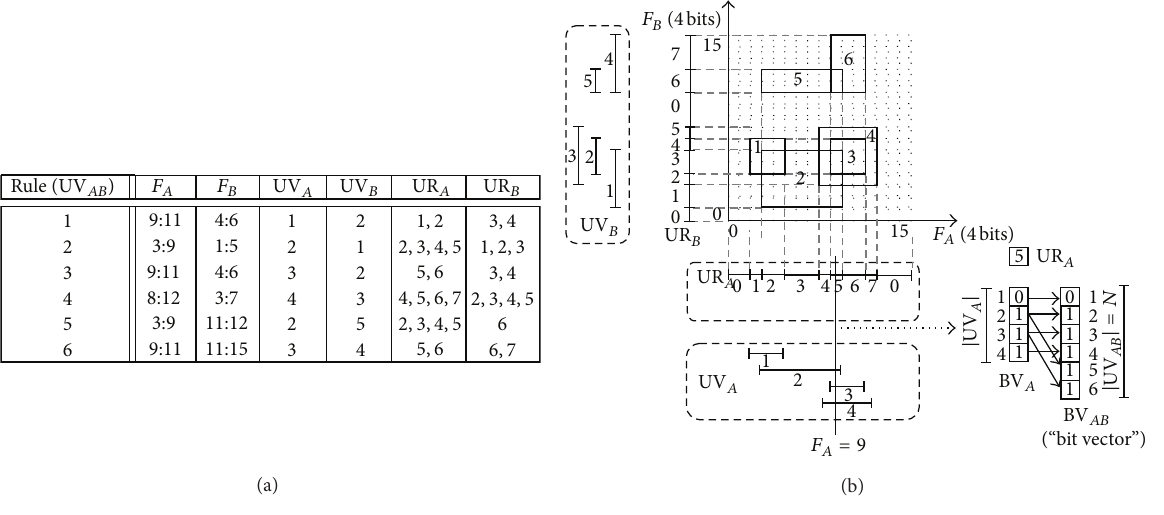
Figure 2: Ruleset example: (a) list of entries and (b) geometric